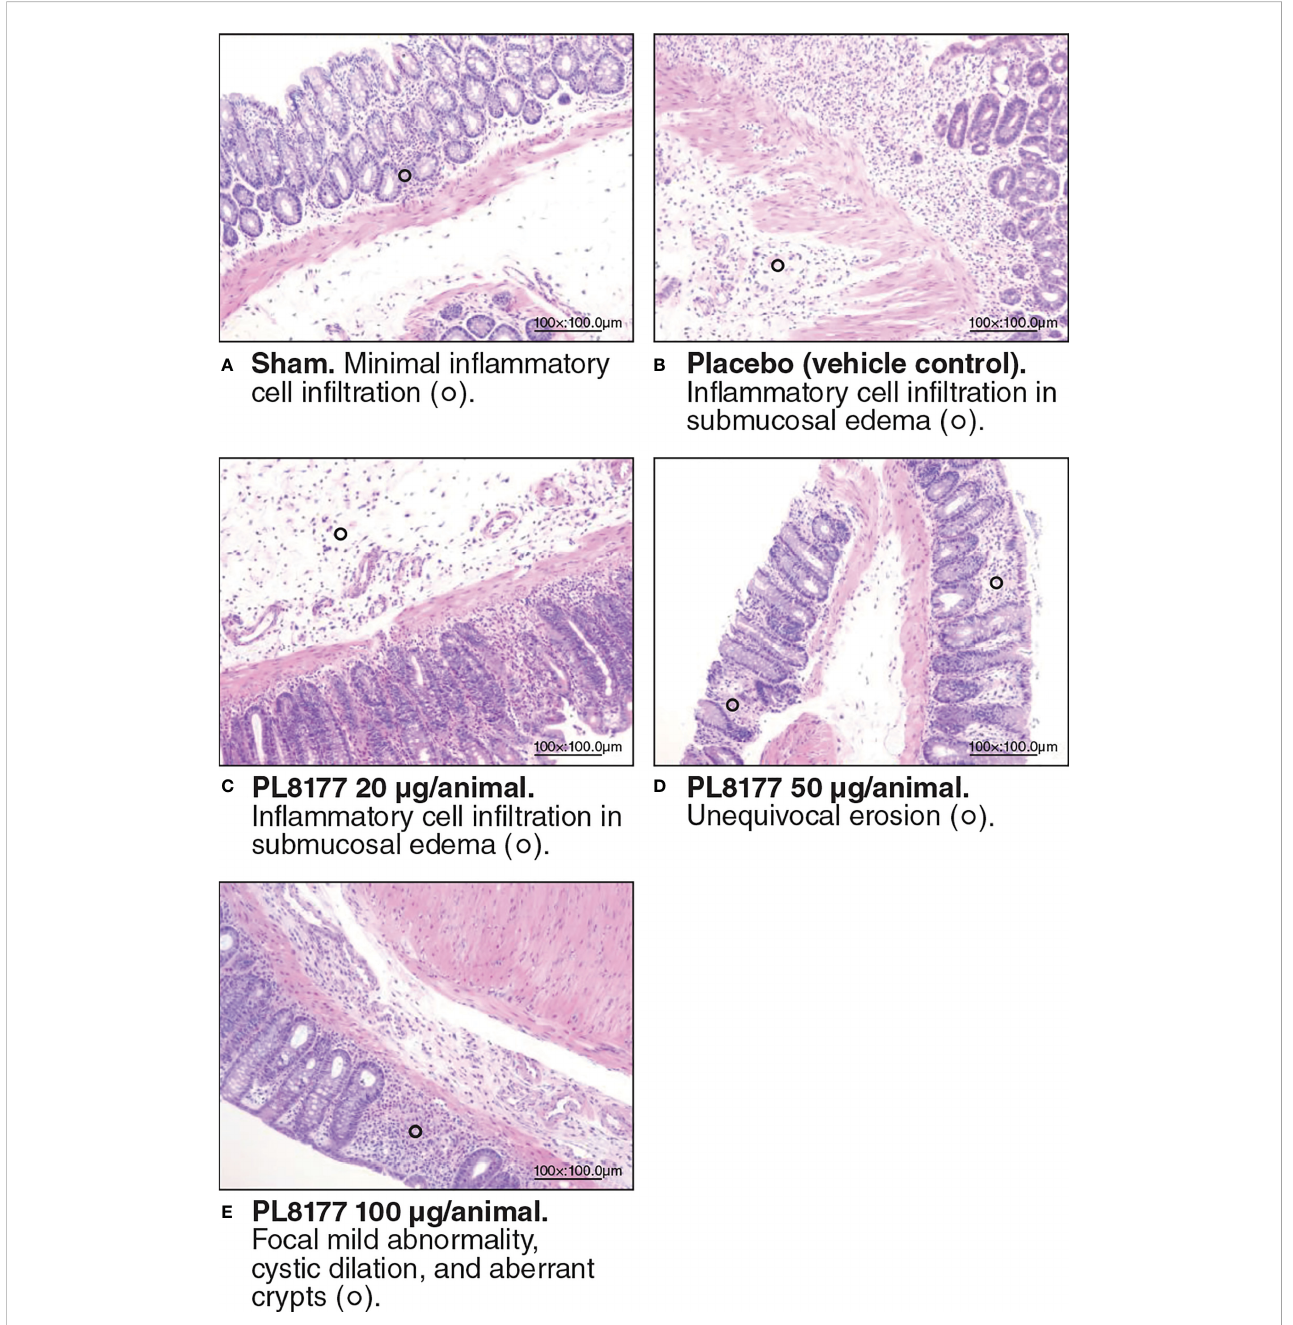
FIGURE 4 Representative colon histologic sections of DSS colitis – induced rats. Sham (A) is no challenge and no treatment. Placebo/vehicle control (B) is no treatment but DSS challenge. (C-E) are DSS challenge and treatment with PL8177. DSS, dextran sulfate